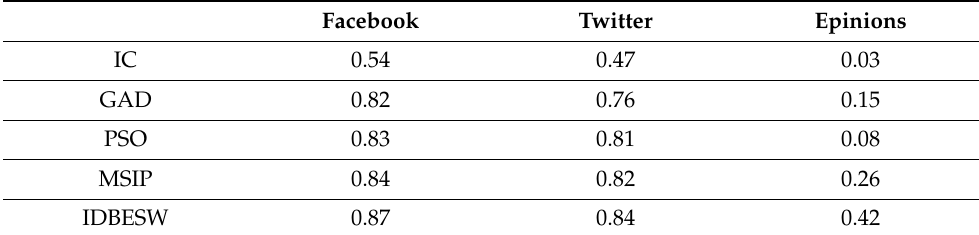
Table 2. Comparison of the proposed model with four rival